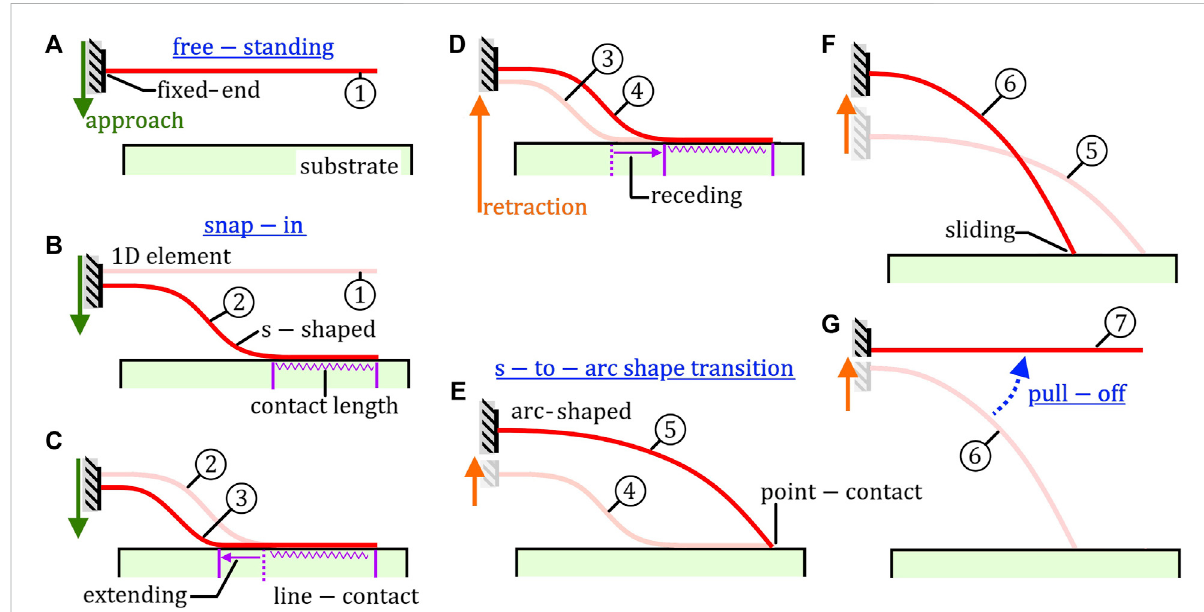
FIGURE 5 Buckling steps exhibited by a parallel-aligned 1D element during approach and retraction from a substrate. Each step is illustrated by the elementbeingshowninstateslabelledfrom1to7. (A) free-standing1Delement(state1). (B) Snap-inof1Delement,formingas-shapedpro fi leanda line-contacton thesubstrate(state 2). (C) Extending ofline-contact during further approach (state 3). (D) Receding of line-contactduring retraction (state4). (E) Pro fi leof1Delementtransitionsfromas-shapedtoanarc-shapedpro fi le(state5). (F) Slidingofpoint-contactatendof1Delement upon further retraction (state 6). (G) Pull-off of 1D element upon further retraction, returning to free-standing state (state